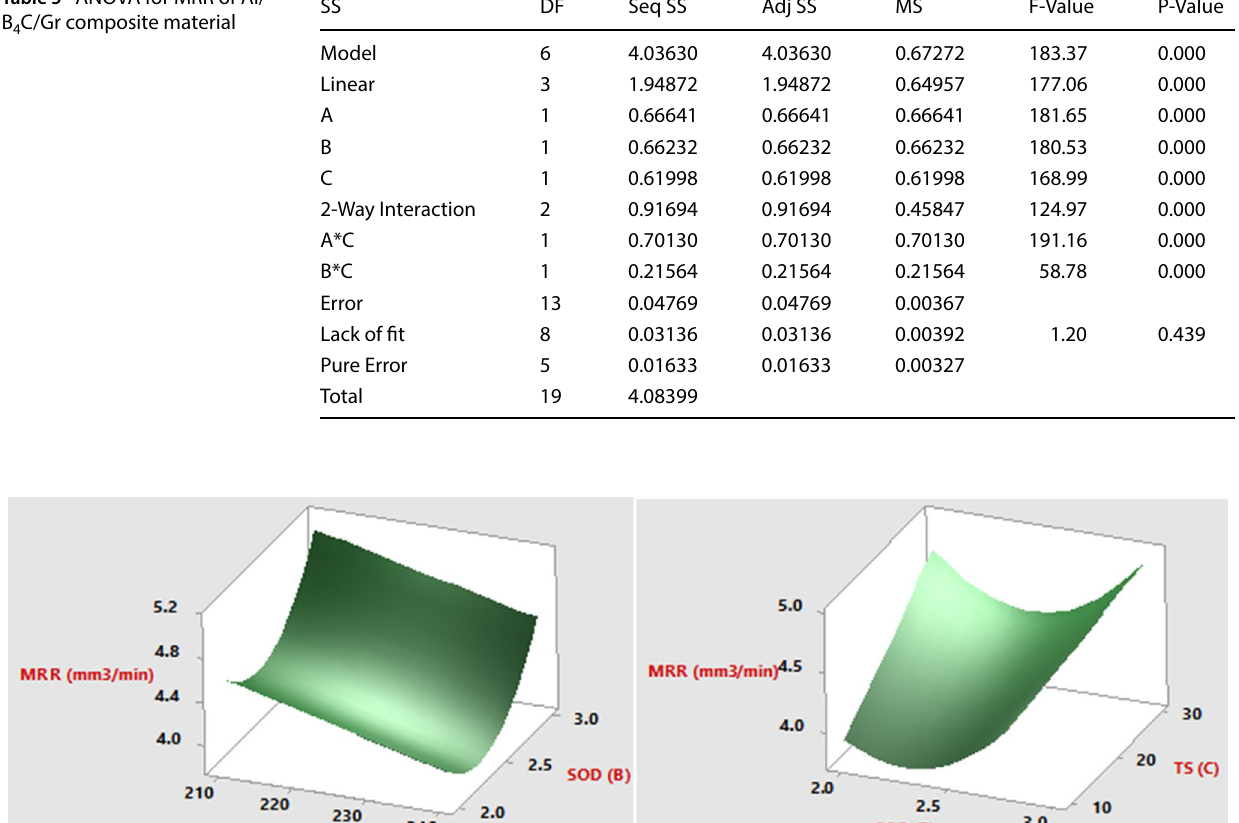
Table 5 ANOVA for MRR of Al/ B C/Gr composite material 4